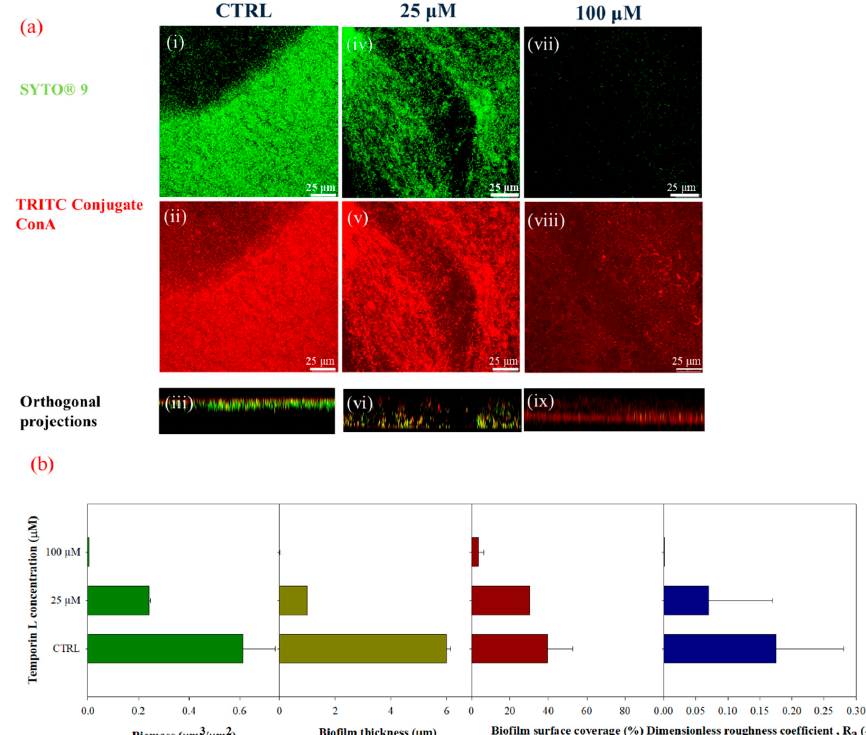
Figure 2. ( a ) CLSM images of 3 days-old-biofilms cultivated under stagnant fluid conditions in green (i, iv, and vii, SYTO ® 9, 3 μ L/mL), red channels (ii, v, and viii, TRITC ConA, 100 μ g/mL) and green (i, iv, and vii, SYTO ® 9, 3 µ L / mL), red channels (ii, v, and viii, TRITC ConA, 100 µ g / mL) and orthogonal projections (iii, vi, and ix) upon TL treatment at two different concentrations (25 μ M and orthogonal projections (iii, vi, and ix) upon TL treatment at two di ff erent concentrations (25 µ M and 100 μ M). (i–iii) CTRL (negative control), (iv–vi) 25 μ M, (vii–ix) 100 μ M; 63X oil immersion 100 µ M). (i–iii) CTRL (negative control), (iv–vi) 25 µ M, (vii–ix) 100 µ M; 63X oil immersion magnification, magnification, scale bar = 25 μ M. ( b ) Morphological parameters were evaluated by processing CLSM scale bar = 25 µ M. ( b ) Morphological parameters were evaluated by processing CLSM stack images stack images of biofilms, cultivated under stagnant fluid conditions at different TL concentrations: Ctrl (negative control), 25 μ M and 100 μ M. Data were calculated from three independent of biofilms, cultivated under stagnant fluid conditions at di ff erent TL concentrations: Ctrl (negative measurements and are reported as average; the standard deviations are indicated. control), 25 µ M and 100 µ M. Data were calculated from three independent measurements and are reported as average; the standard deviations are